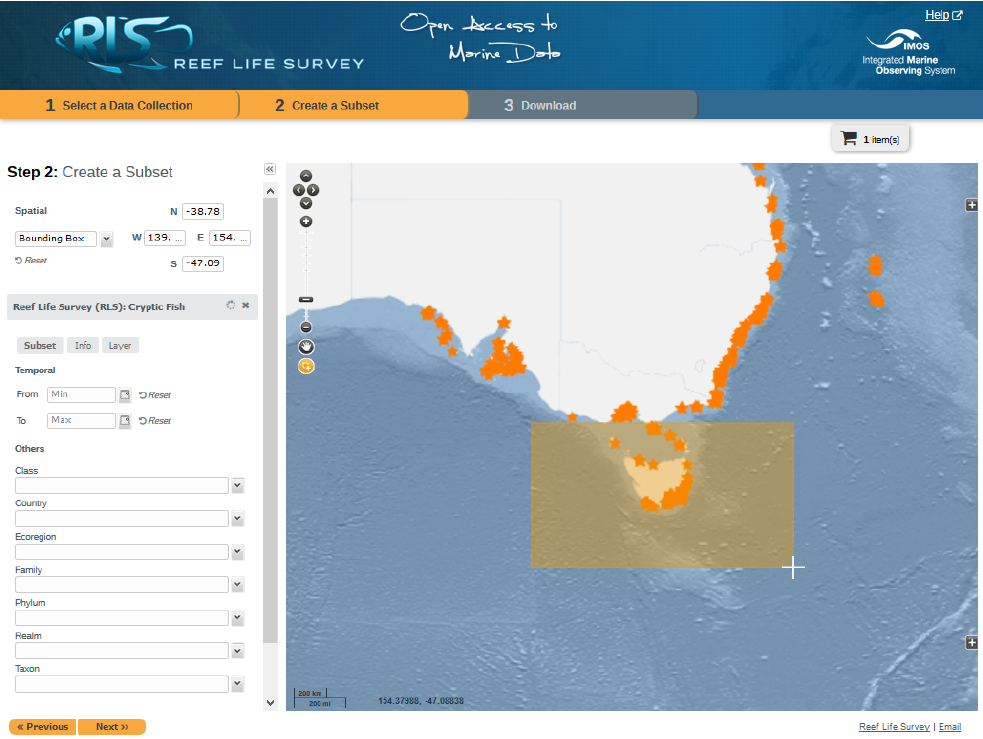
Figure 11. The selection of data subset on the Reef Life Survey data